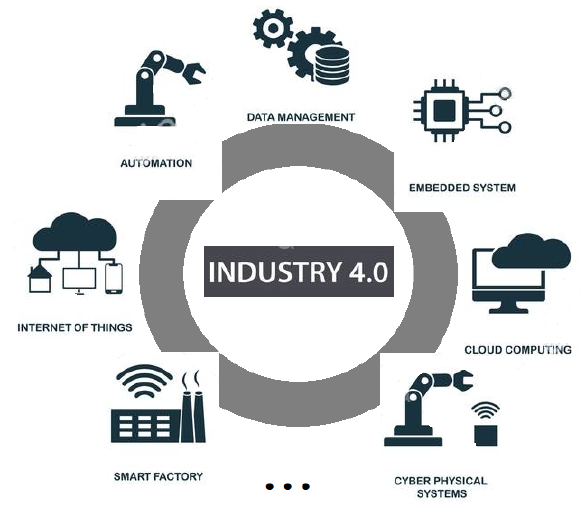
Figure 1. Industry